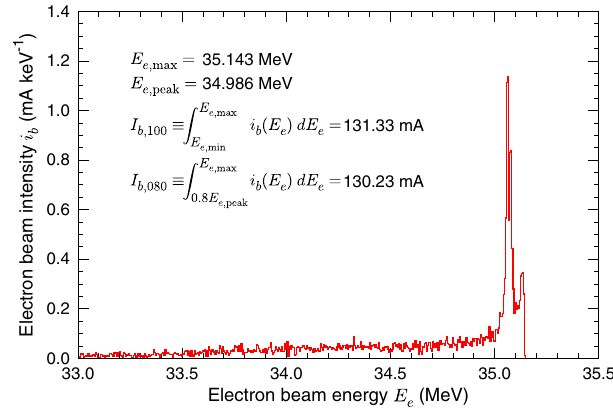
FIG. 10. Beam energy and current at the beam exit z ¼ 5 m obtained from GPT ; i the lowest and highest beam energies, respectively; E beam energy at which i